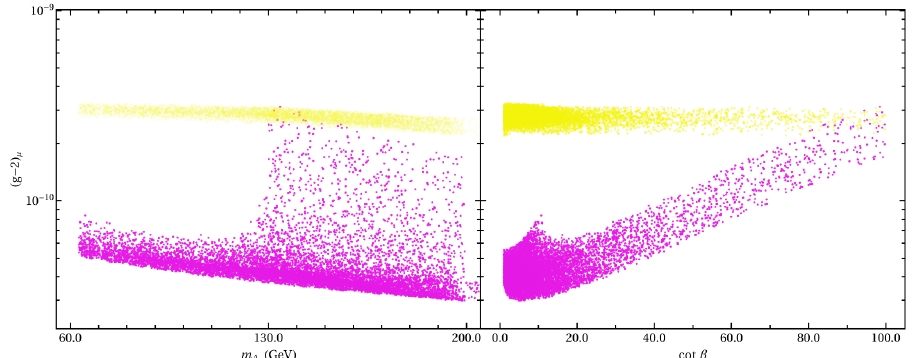
Figure 7 . Values for ( g − 2) µ in the effective 3-3-1 model. In purple we show the fermionic contributions (2-loop Barr-Zee diagrams) plus the 1-loop contributions. In yellow we show the absolute value of the bosonic contribution (which is always negative in the region scanned). All points comply with theoretical